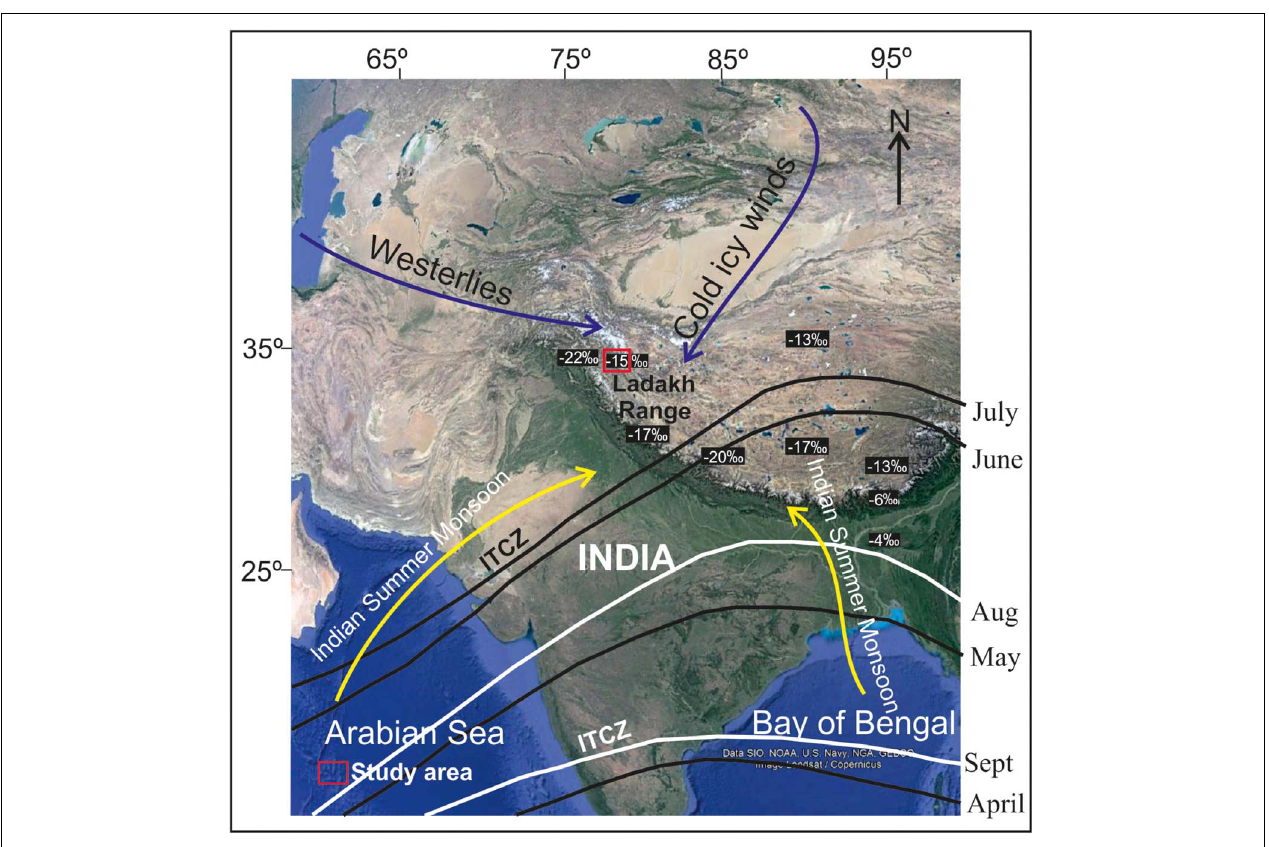
FIGURE 5 | Google image of India showing different moisture sources to NW trans -Himalayan regions. Also shown the position of ITCZ during ISM (source for ISM trend lines: https://www.pmfias.com/indian-monsoons-south-west-north-east-monsoons-itcz/). The solid black and white ITCZ trend-lines showing that with increasing temperature, the ITCZ keeps moving northward (April–July) and from August onwards, the direction of ITCZ trend becomes southward, respectively. It is important to note that in abnormal monsoon years (ITCZ moves further north), appreciable amounts of monsoon winds crossover the Himalayas and bring more rain and snow to trans -Himalayan regions. The δ 18 O isotopic composition is also marked in the figure (for details see Sharma et al.,